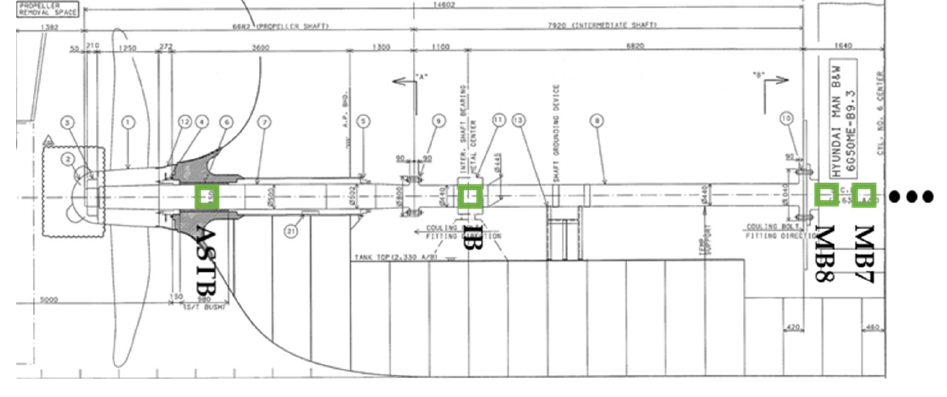
Figure 2. Bearing positions of target